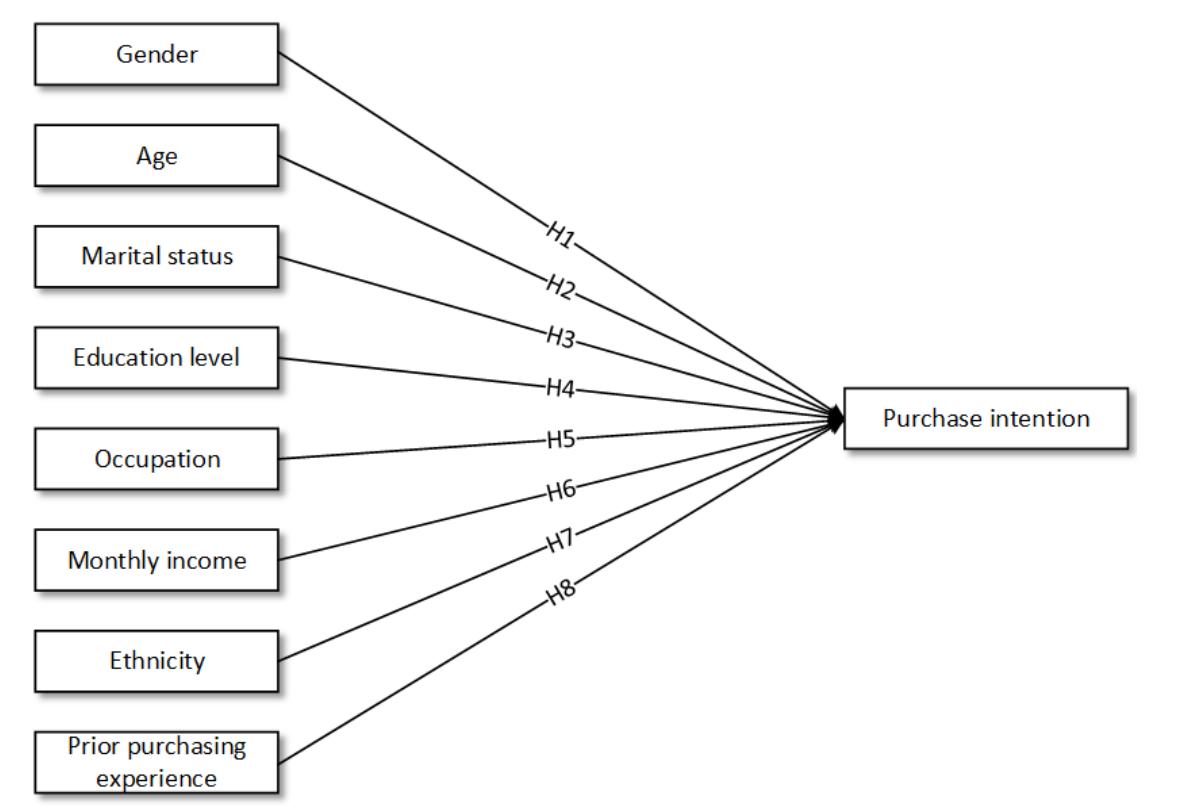
Figure 1. Socio-demographic characteristics and intention to purchase organic food (H1 – H8).